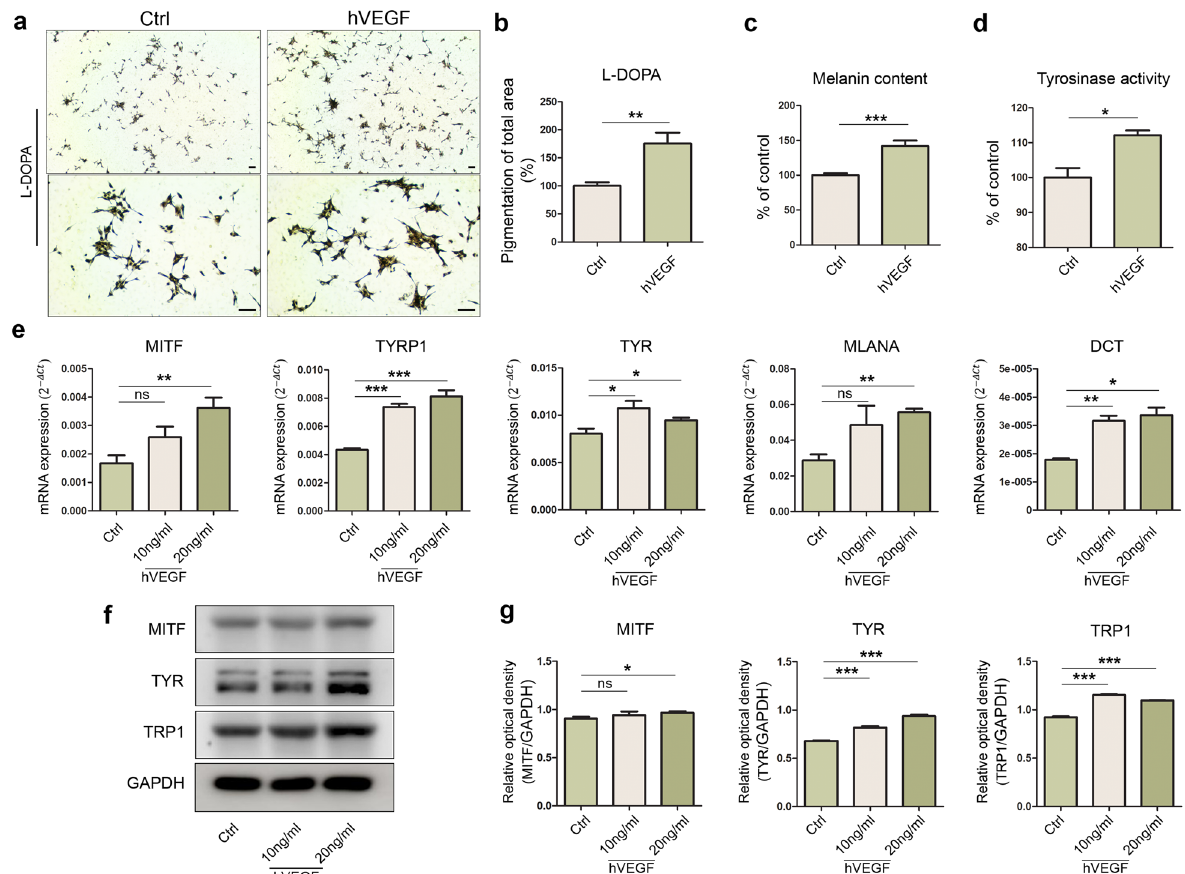
Figure 6. Effect of hVEGF on melanin synthesis in hiMels. ( a ) L-DOPA staining in hiMels following 20 ng/ mL VEGF treatment for 72 h. ( b ) Quantification of total pigmentation area. ( c ) Changes in melanin content in hiMels treated with 20 ng/mL VEGF. ( d ) Quantification of tyrosinase activity in hiMels treated with 20 ng/ mL VEGF. ( e ) Expression of pigmentation markers MITF , TYRP1 , TYR , MLANA , and DCT upon treatment with VEGF. The relative gene expression values were calculated using the delta cycle-threshold (ΔCt) method. ( f ) Western blot analysis of MITF, TYR, and TRP1 in cell lysates. GAPDH was used as a loading control. ( g ) MITF, TYR, and TRP1 quantification using ImageJ software. Data are expressed as the mean ± SEM. * p < 0.05, ** p < 0.01, *** p < 0.001 indicate statistical significance. L-DOPA 3,4-dihydroxyphenylalanine, ns